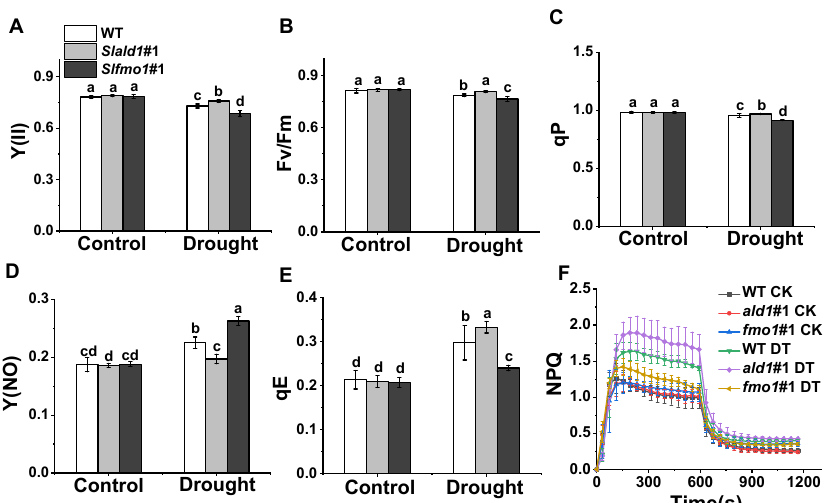
Figure 4. Changes in PSII in Slald1 and Slfmo1 mutants under drought stress. PSII energy conver ‐ sion: Y(II) ( A ), Fv/Fm ( B ), qP ( C ), Y(NO) ( D ), qE ( E ) and NPQ kinetics ( F ) in Slald1 , Slfmo1 mutants and WT plants after 48 h of control and drought treatment. CK represents control, and DT represents drought. The data are presented as mean values ± SD, n = 4. Different letters (a,b,c,d) above each bar indicate significant differences at p < 0.05 (Tukey’s test) among treatments.